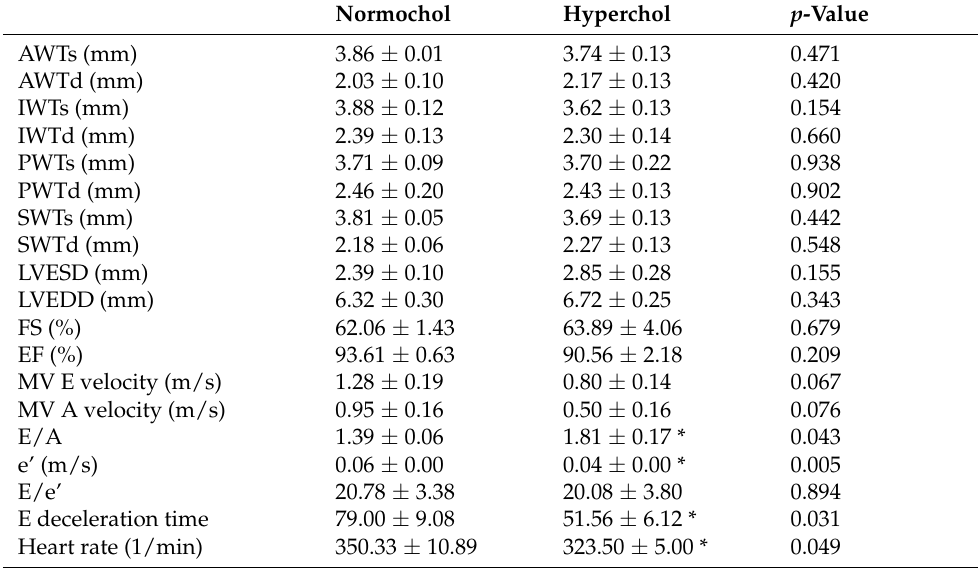
Table 2. Diet-induced hypercholesterolemia leads to cardiac dysfunction. Left ventricular morpho- logical and functional parameters examined by echocardiography after the 8-week diet period in both normocholesterolemic (Normochol) and hypercholesterolemic (Hyperchol) rats. Values are the mean ± SEM ( n = 6), * p < 0.05. AWT: anterior wall thickness, d: diastolic, MV A: late (atrial) ventricular filling velocity measured at the mitral valve, MV E: early ventricular filling velocity measured at the mitral valve, e’: septal mitral annular velocity, EF: ejection fraction, FS: fractional shortening, IWT: inferior wall thickness, LVEDD: left ventricular end-diastolic diameter, LVESD: left ventricular end-systolic diameter, PWT: posterior wall thickness, s: systolic, and SWT: septal wall thickness.